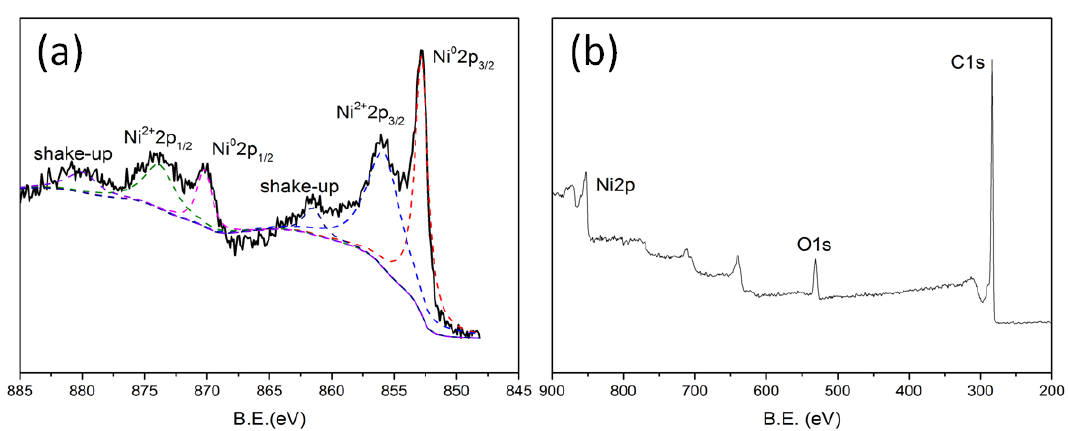
Figure 2. Characterization of the 20% Ni/CNT catalyst. ( a ) XPS of Ni 2p, ( b ) XPS pattern of 20% Ni/CNT.